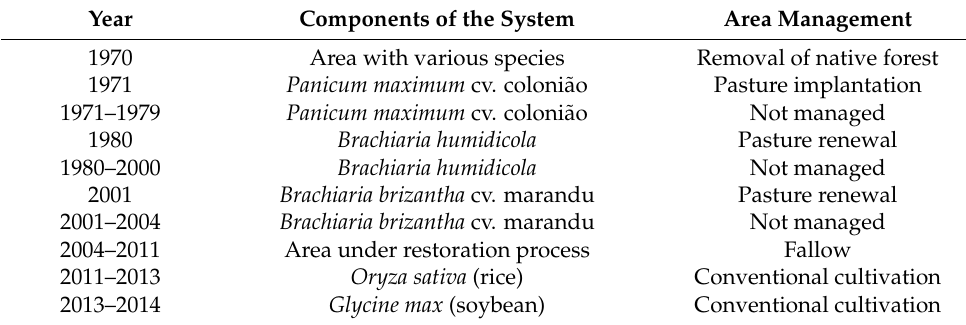
Figure 2. Average temperature and precipitation ( a ), extract from the water balance ( b ), during the period from January 2015 to January 2018, in the mesoregion of southeastern of Pará, Brazil. The management history of the case study area is shown in Table 1. Table 1. Study area, Fazenda Jaspe, town of Ulianópolis, Pará, Brazil.